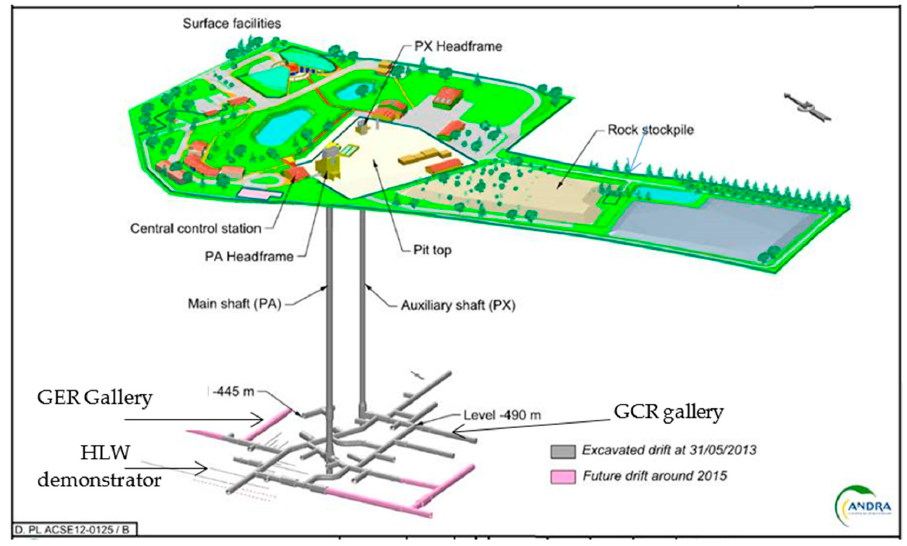
Figure 9. Schematic representation of the Andra’s URL and instrumented galleries (GER and GCR). Two ILW-LL cell monitoring demonstrators were realized [24,25]. They are tunnels of 5 m external diameter, with a shotcrete layer covering the host rock, a layer of poured concrete covering the shotcrete, basement construction, then slab and finally vault. In 2011 (respectively 2015), the “GCR” (resp. “GER”) gallery was dug according to the major (resp. minor) horizontal stress field. In these two galleries, several instrumented sections were implemented (see Figure 10), equipped with both classical and innovative sensor technologies (i) Fibre Optic Sensors (FOS), Vibrating Wire Extensometers (VWE), total pressure cells in the shotcrete; (ii) FOS, displacement sensors and pore water pressure in boreholes; (iii) FOS, VWE, Time Domain Reflectometry sensors (TDR) for water content measurement, permeability pulse sensor, total pressure cell. Such structures allow to test temperature and strain measurement solutions in real operating conditions. An instrumented HLW- LL demonstrator had also been realized and is depicted in details in [26].